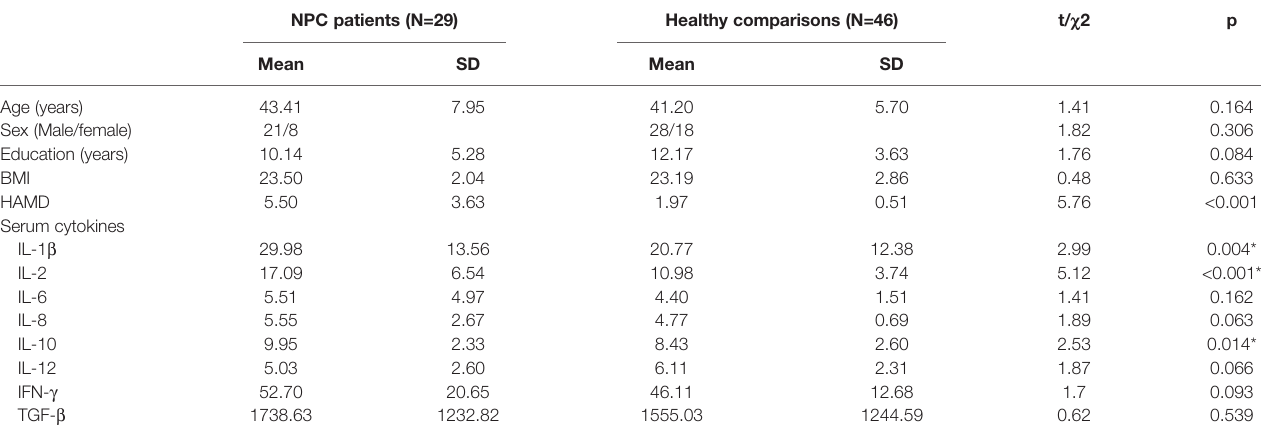
TABLE 1 | Demographic and clinical characteristics of the patients with nasopharyngeal carcinoma and healthy